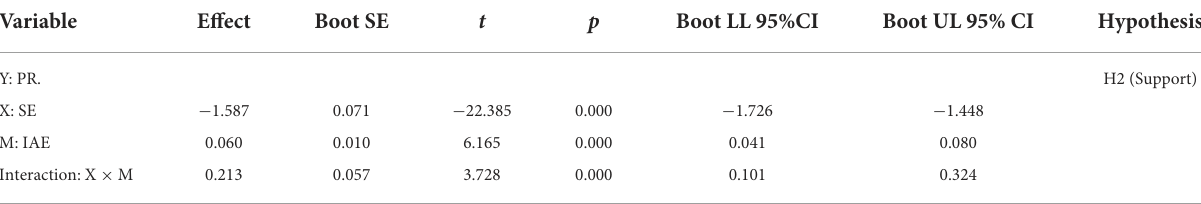
TABLE 6 International assignment experience modifies the relationship between stressors during COVID-19 and mental health. Variable